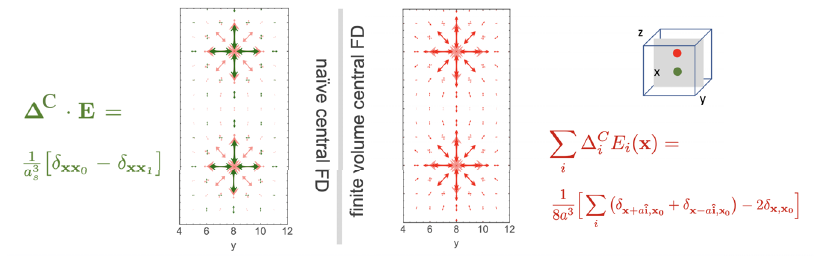
Figure 4. Example of the di ffi culty encountered in discretizing Gauss’ law with central finite di ff er- ences. (left) Using a naive central finite di ff erence discretization an artificial staggered pattern of field lines (green arrows) emerges which does not accurately reproduce the correct solution (light red ar- rows). (right) A finite volume discretization based on distributed sources achieves closed field lines (dark red arrows) and conserves the integral form of Gauss’ law within the accuracy of the discretiza-